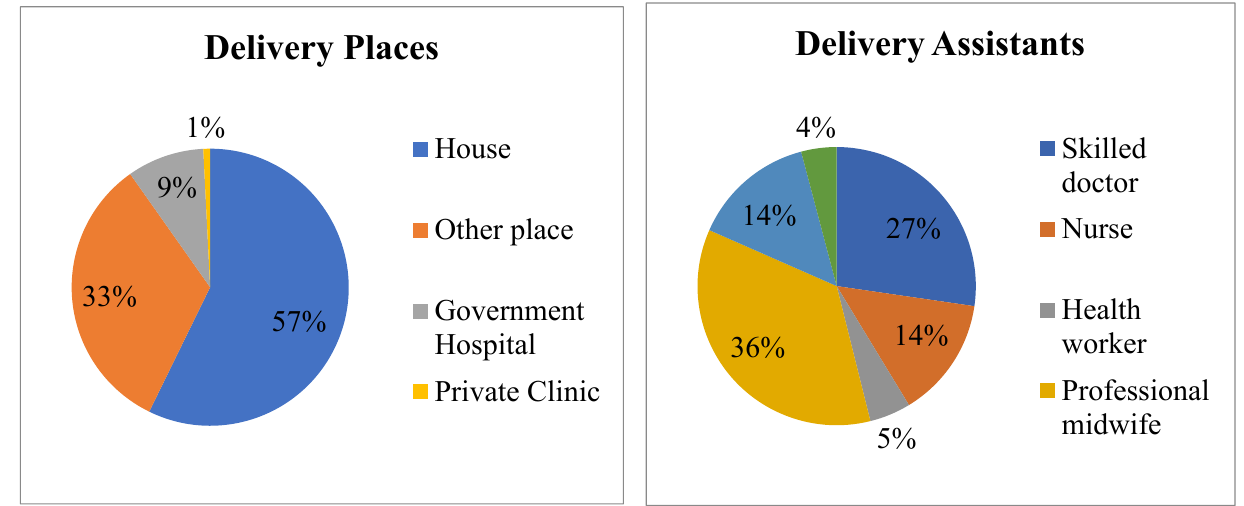
Figure 1. Distribution of the delivery places ( left ) and assistants of the respondents’ last childbirth ( right ).